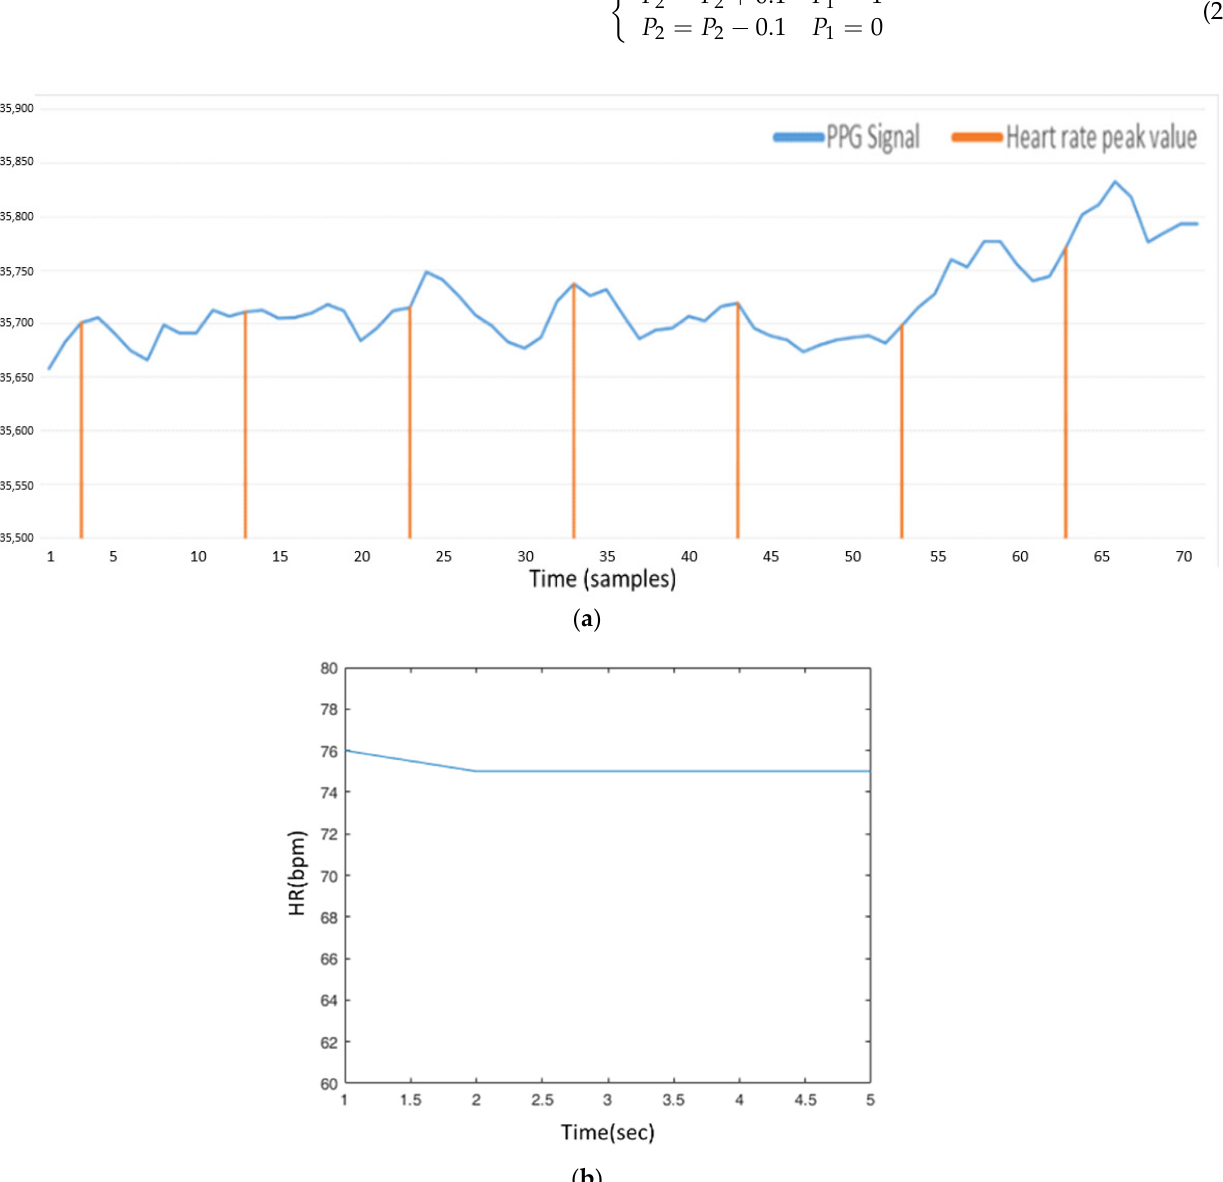
Figure 21. ( a ) AMPD algorithm with Laplacian (AMPD Threshold = 6/𝐿 , L = 7); ( b ) Heart rate signal (AMPD Threshold = 6/𝐿 , L = 7).